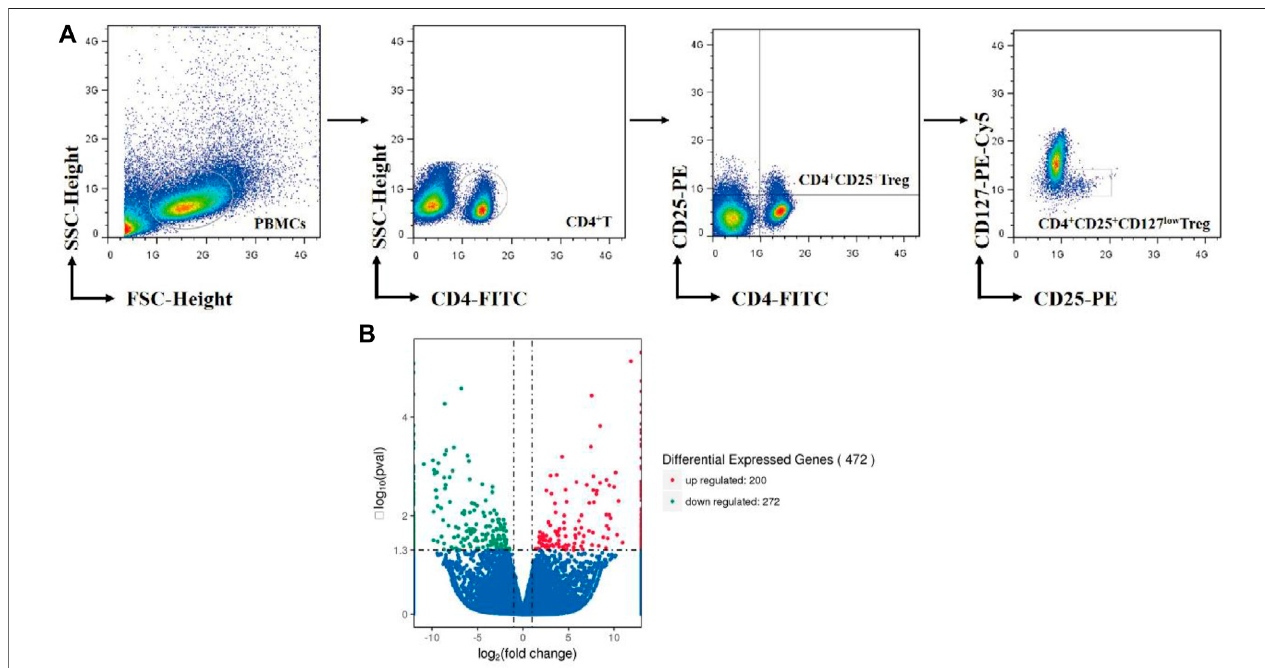
FIGURE 1 | (A) Overview of Treg-cell isolation by cell sorter. (B) Volcano Plots include all differential expressed genes absolute value log2-fold change > 0.5. Red nodes represent upregulation and blue nodes represent downregulation in treatment Treg cells compared to nontreatment Treg cells.